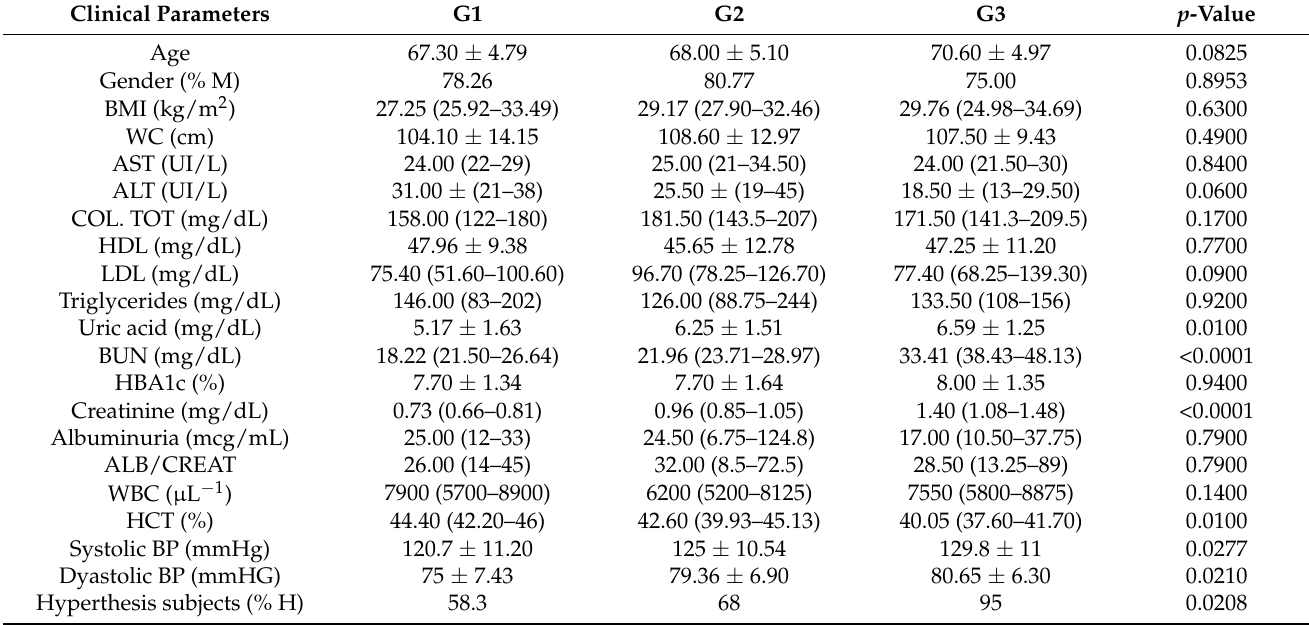
Table 1. Demographic and clinical data of the validation cohort. WC: Waist Circumference; BUN: Blood Urea Nitrogen; HbA1c: Hemoglobin A1; WBC: White Blood Cells; HCT: